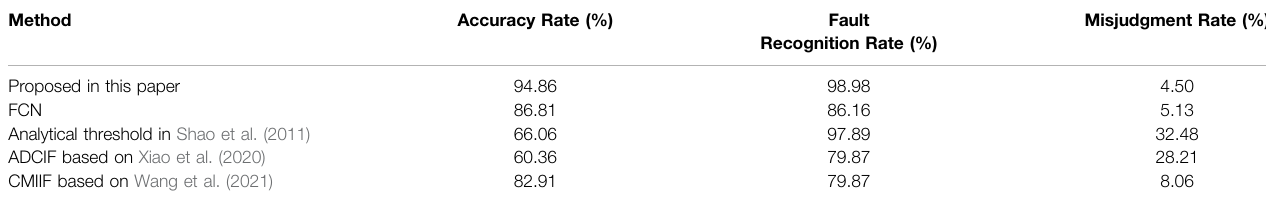
TABLE 2 | Test result in customized IEEE 39 bus system.